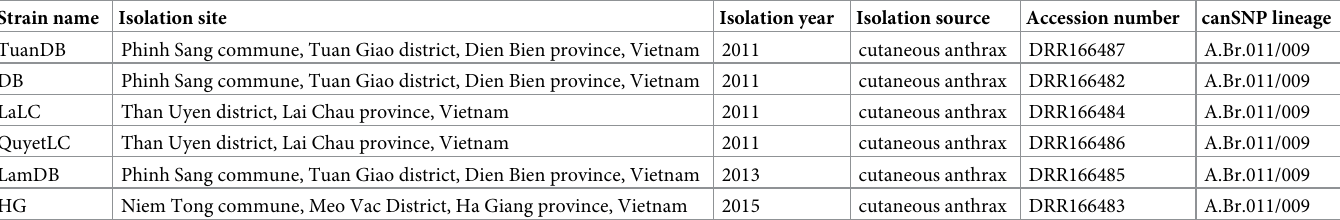
Table 1. Profiles of six Vietnamese B . anthracis strains belonging to A.Br.011/009 canSNP